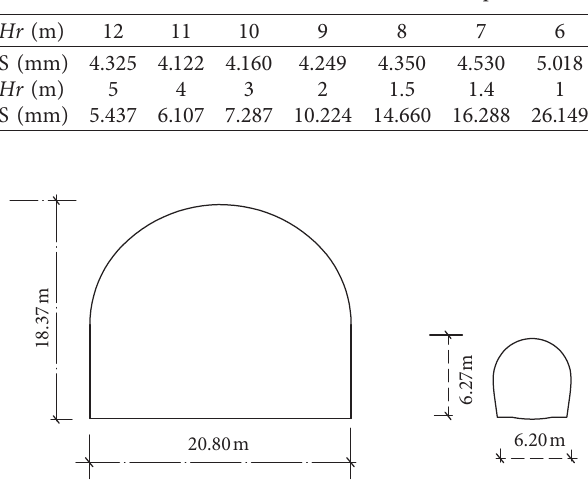
Figure 4: Section size.